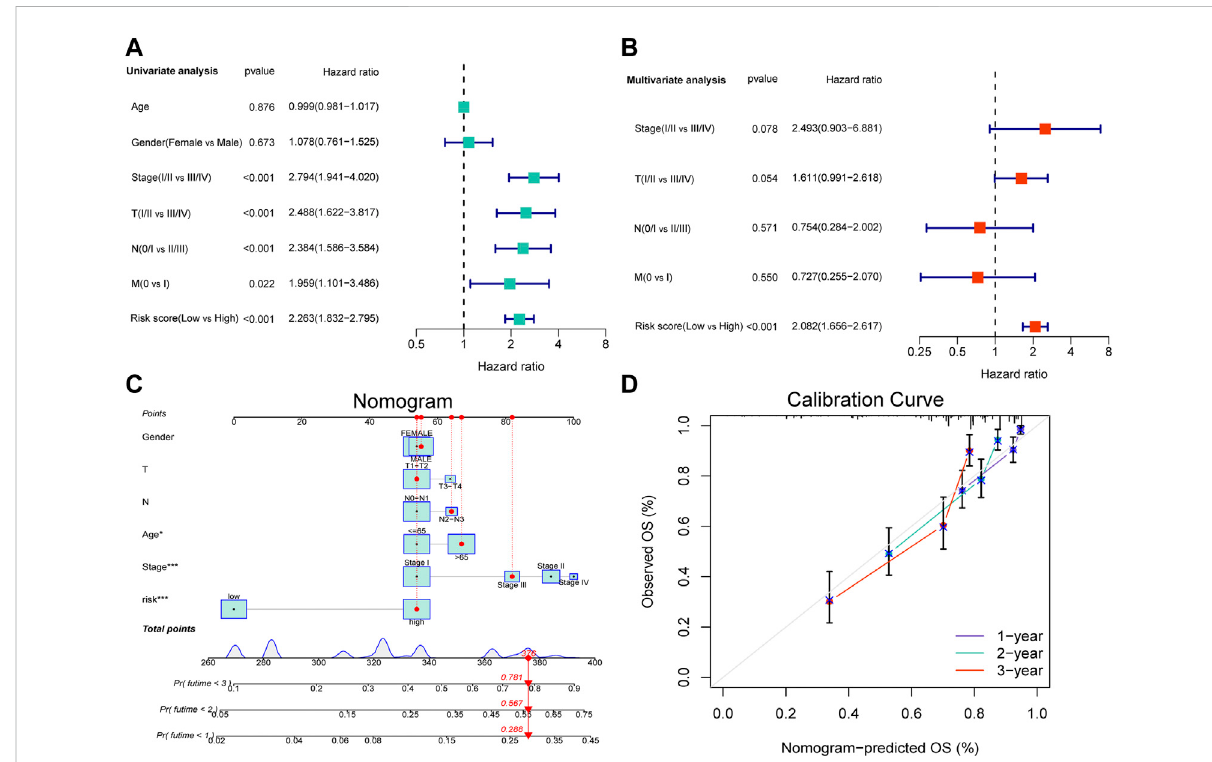
FIGURE 4 Independent prognostic analysis of the NRL signature and construction of nomogram and calibration. (A) The hazard ratio (HR) and 95% con fi dence interval of risk score and all clinical features were calculated using the univariate Cox regression analysis. (B) The hazard ratio (HR) and 95%con fi denceinterval ofriskscoreandall clinicalfeatureswerecalculatedusingthemultivariateCoxregressionanalysis.Thefactorinthisanalysis could be considered as an independent prognostic factor when p -values were both < 0.05 in (A,B) . (C) The nomogram that includes the risk score,age,sex,Tstage,Nstage,andclinicalstages predictedtheprobabilityofthe1-,2-,and3-yearsOS. (D) Thecalibrationcurvesforthepredicted 1-, 2-, and 3-years OS